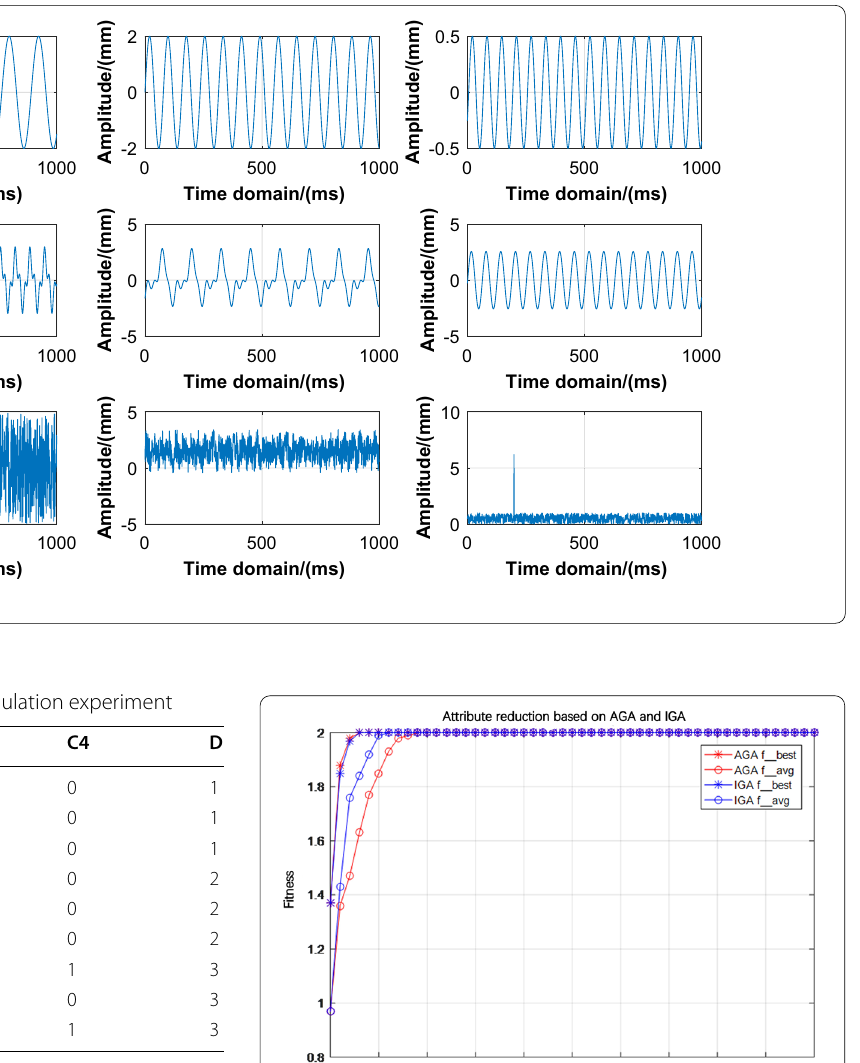
Figure 4 Attribute reduction based on the adaptive genetic algorithm and improve genetic the optimal solution is obtained in the third iteration of each algorithm. The population average fitness of the improved genetic algorithm is optimized at the fifth iter- ation and that in the adaptive genetic algorithm is opti- mized in the eighth iteration. The optimization result of both algorithms is {1010} and the decision rule in Table 2 can be obtained by deleting repeated elements. Figure 4 and Table 2 indicate that there is no signifi- cant difference between the two algorithms when the number of simulation experimental data is small. How- ever, the population evolution speed of the improved genetic algorithm is significantly higher than that of